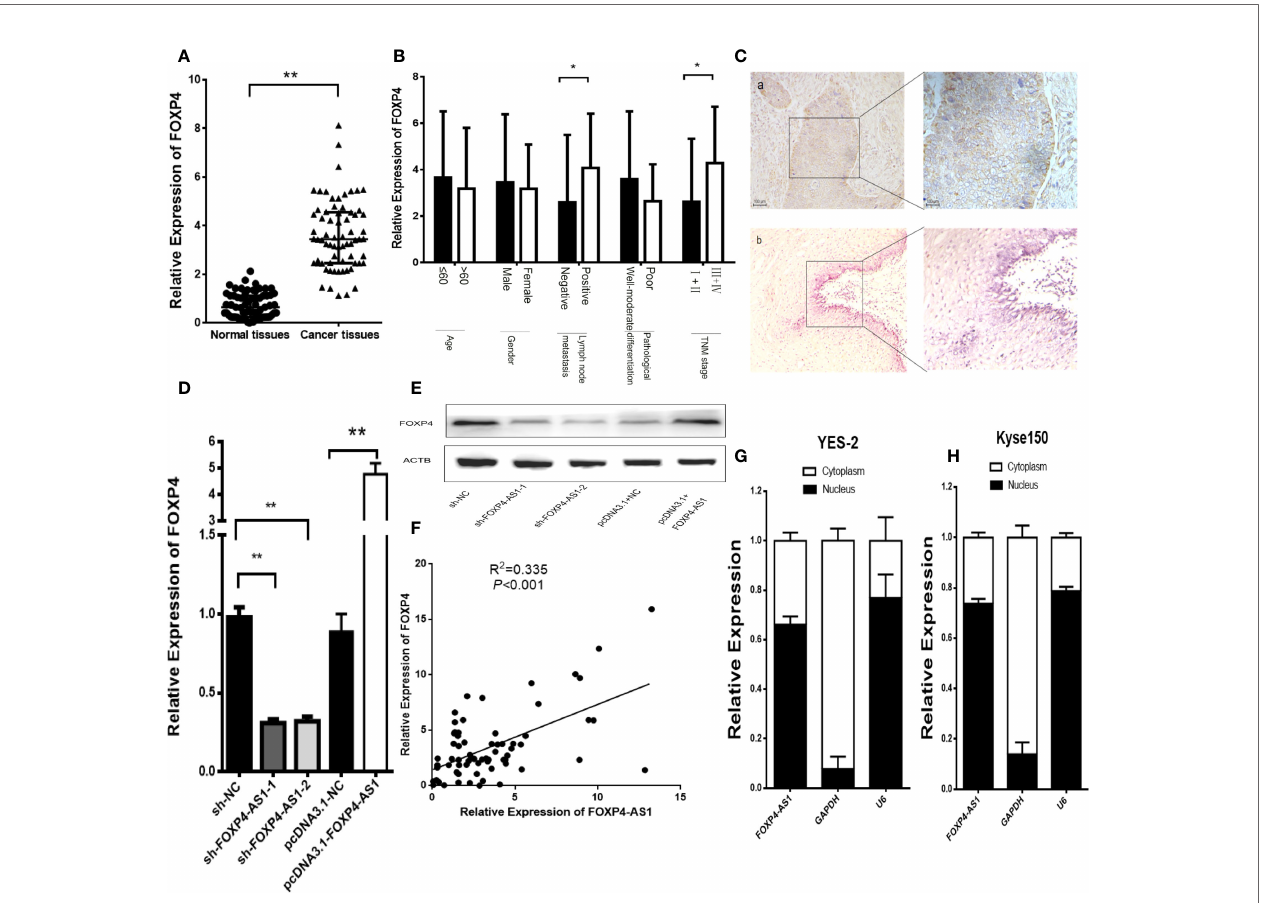
FIGURE 3 | FOXP4 is highly expressed in ESCC and increased by FOXP4-AS1 at the mRNA and protein levels. The expression of FOXP4 in ESCC tissues (A) and different subgroups (B) by qRT – PCR. (C) FOXP4 protein in ESCC by IHC (SP Left×200; Right×400). a: ESCC tissue; b normal tissue. FOXP4 mRNA (D) and protein (E) levels with FOXP4-AS1 by qRT – PCR or WB. (F) The correlation between FOXP4-AS1 and FOXP4 by qRT – PCR. Subcellular localization of FOXP4-AS1 in YES-2 (G) and Kyse150 (H) , GAPDH and U6 were used as cytoplasmic and nuclear controls. * p < .05 and ** p <